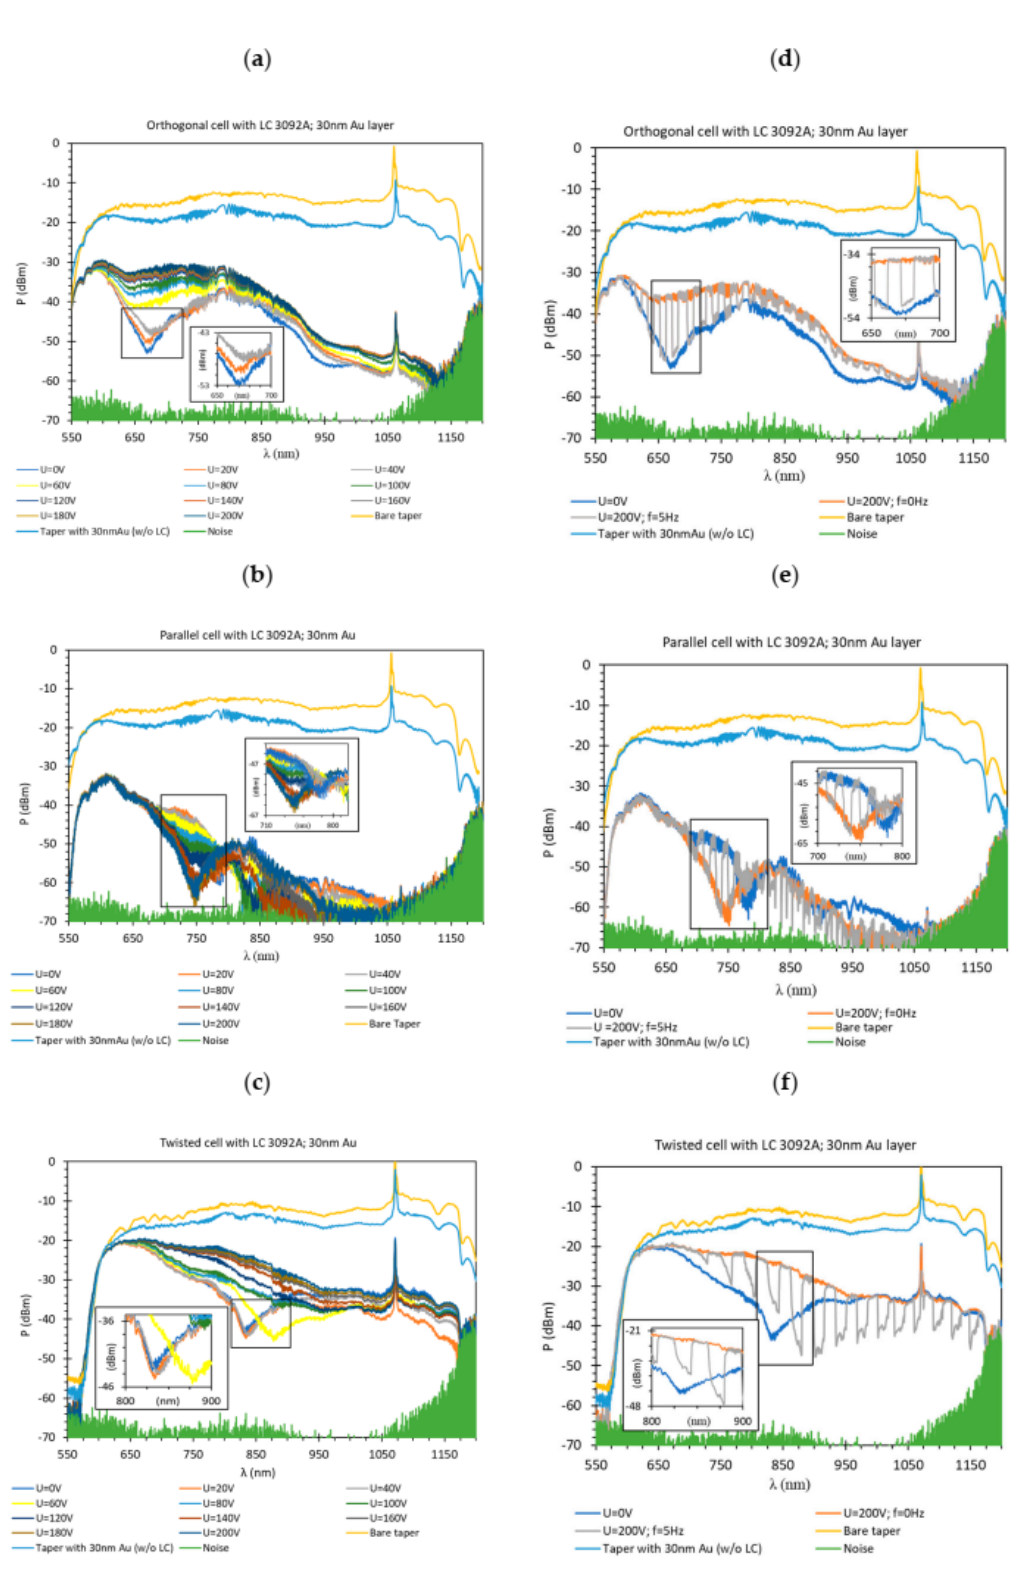
Figure 8. The spectra obtained for a LC cell with deposited 30 nm gold layers ( a ) orthogonal; ( b ) parallel; and ( c ) twisted, under steering voltage U in the range of 0–200 V. Spectra obtained for: ( d ) orthogonal; ( e ) parallel; and ( f ) twisted cell for the steering voltage U = 0 and 200 V without, and with a 100% depth AM, at frequency f = 5